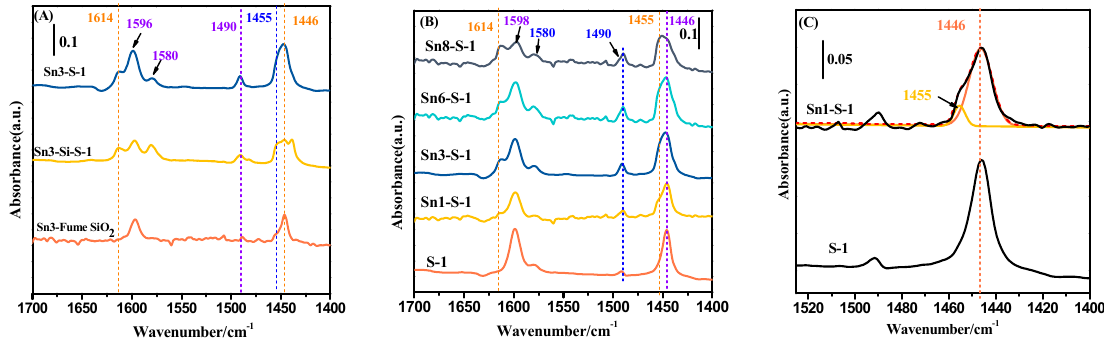
Figure 7. Pyridine adsorption FT-IR spectra (evacuated at 350 °C) of Sn-containing catalysts with different matrixes ( A ), Sn-containing defective S-1 zeolite catalysts with different Sn loadings ( B ) and the deconvolution of the main absorption band of Sn1-S-1 sample at low frequency ( C ).